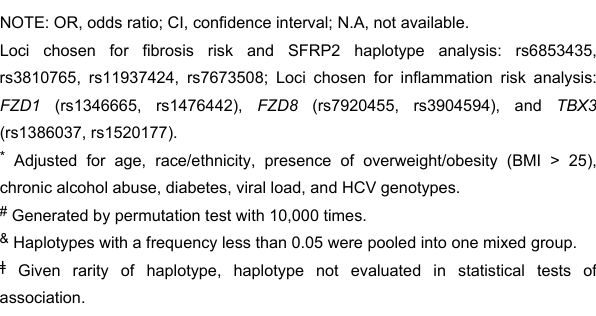
Table 4. Haplotype analyses and associations with advanced hepatic fibrosis or inflammation risk in patients with HCV